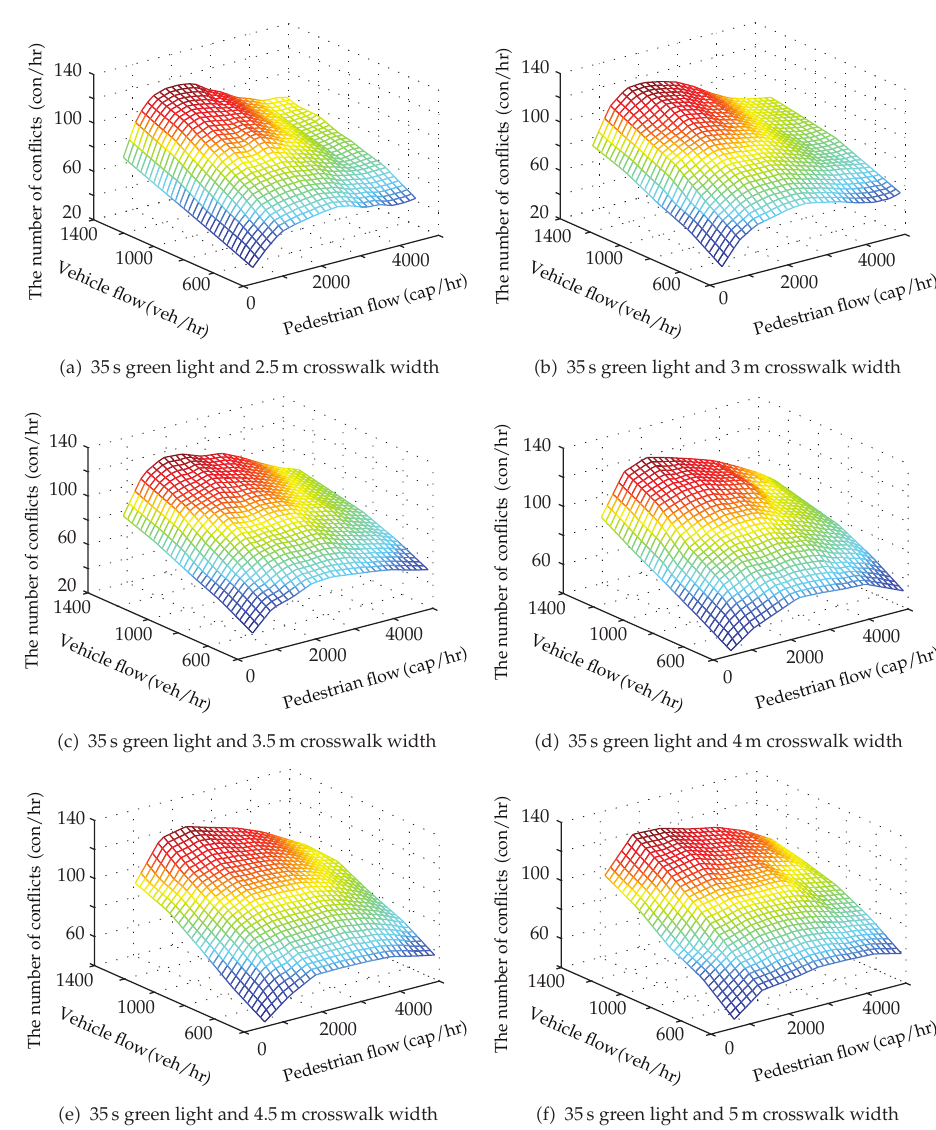
Figure 6: Relationship among pedestrian flow, vehicle flow, and the number of conflict events between pedestrians and vehicles for di ff erent types of crosswalk